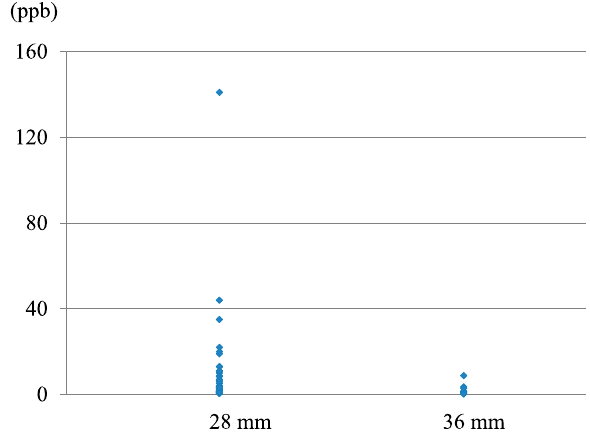
Figure 5 Serum cobalt ion concentration and femoral head diameter The femoral head diameter was 28 mm in 39 patients and 36 mm in 9 patients, but no correlation was observed with the serum cobalt ion